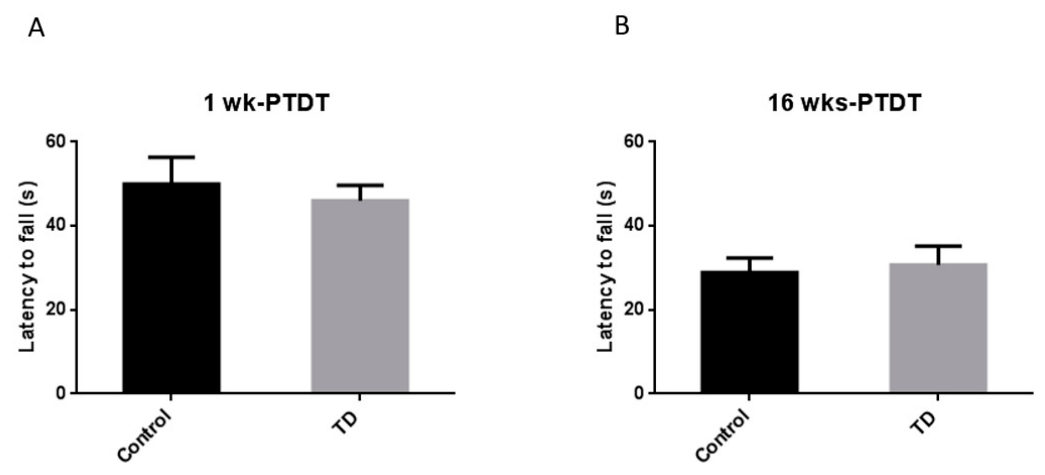
Figure 5. The results of the rotor rod (RR) test of the two cohorts after TD treatment. The latency to fall was recorded for the 1 wk-PTDT cohort ( A ) and the 16 wks-PTDT cohort ( B ). For the 1 wk-PTDT cohort, n = 10 for both control and TD groups. For the 16 wks-PTDT cohort, n = 10 for the control group, and n = 9 for the TD group.